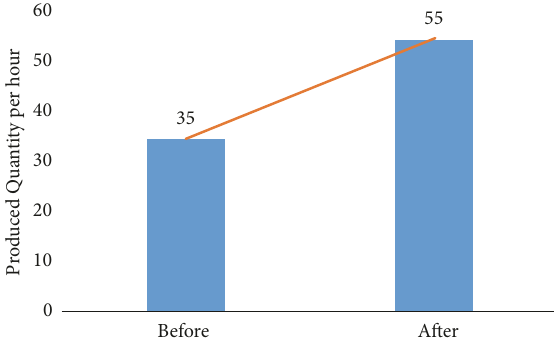
Figure 9: Before and after production quantity per hour.